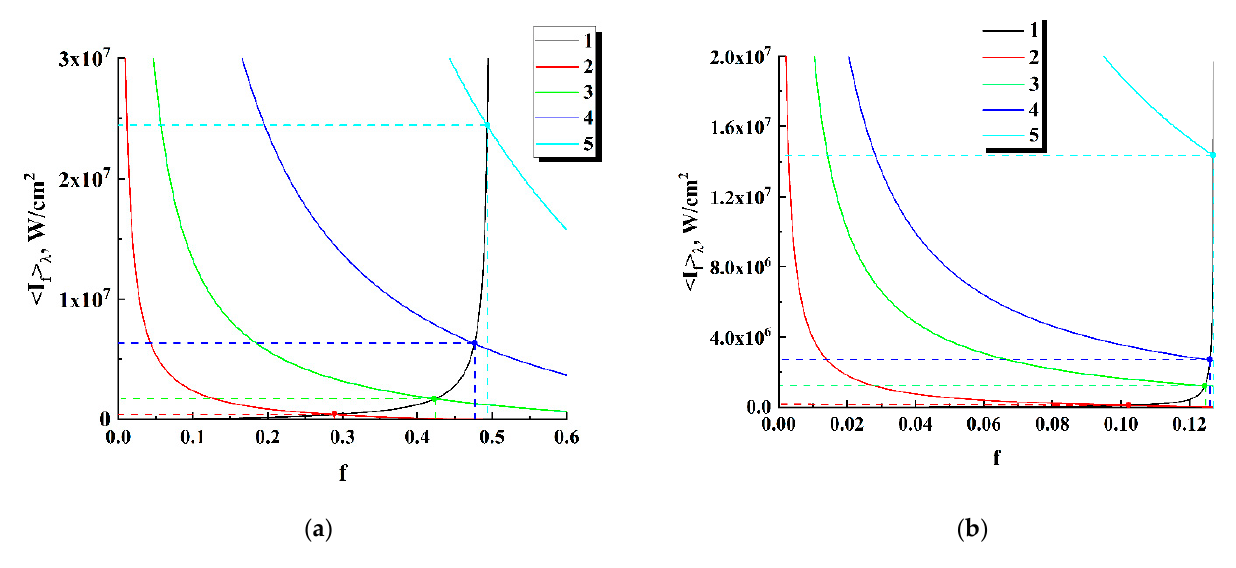
Figure 8. Graphical interpretation of the solution of System (11). Curve (1) corresponds to the first equation; curves (2–5) correspond to the second equation at various values of the pump intensity. Horizontal and vertical dashed lines mark unique solutions of (11) for the given pump intensities. ( a ) R6G-filled local emitter, I p = 1 × 10 6 W/cm 2